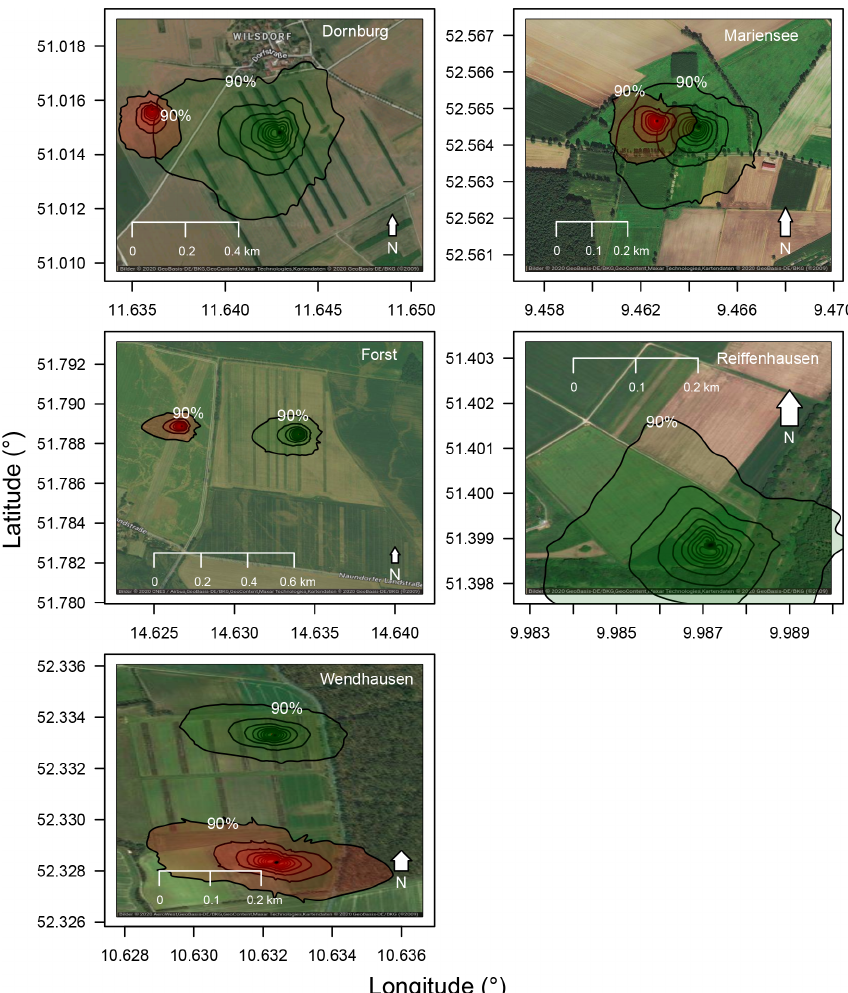
Figure 3. Flux footprint climatologies for all sites for the respective campaign period. Green shaded footprints correspond to the AF system, and red shaded footprints correspond to the MC system. For the analysis only daytime data were used ( R G > 20Wm − 2 ). Isolines correspond to a 10% to 90% flux magnitude contribution in 10% steps, with the 90% isoline labelled in the system. The flux footprint climatology for Reiffenhausen MC is missing due to the unavailability of a campaign. Aerial photographs originate from Google Maps and Google